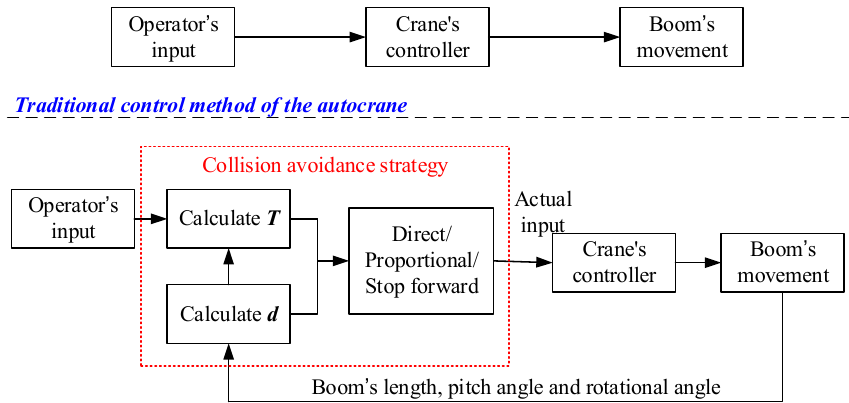
Figure 5. Control method with and without the collision avoidance strategy.